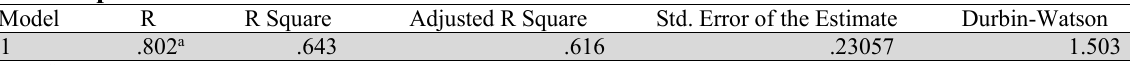
Level of explanation of the model Model R R Square Adjusted R Square Std. Error of the Estimate Durbin-Watson 1 .802 a .643 .616 .23057 1.503